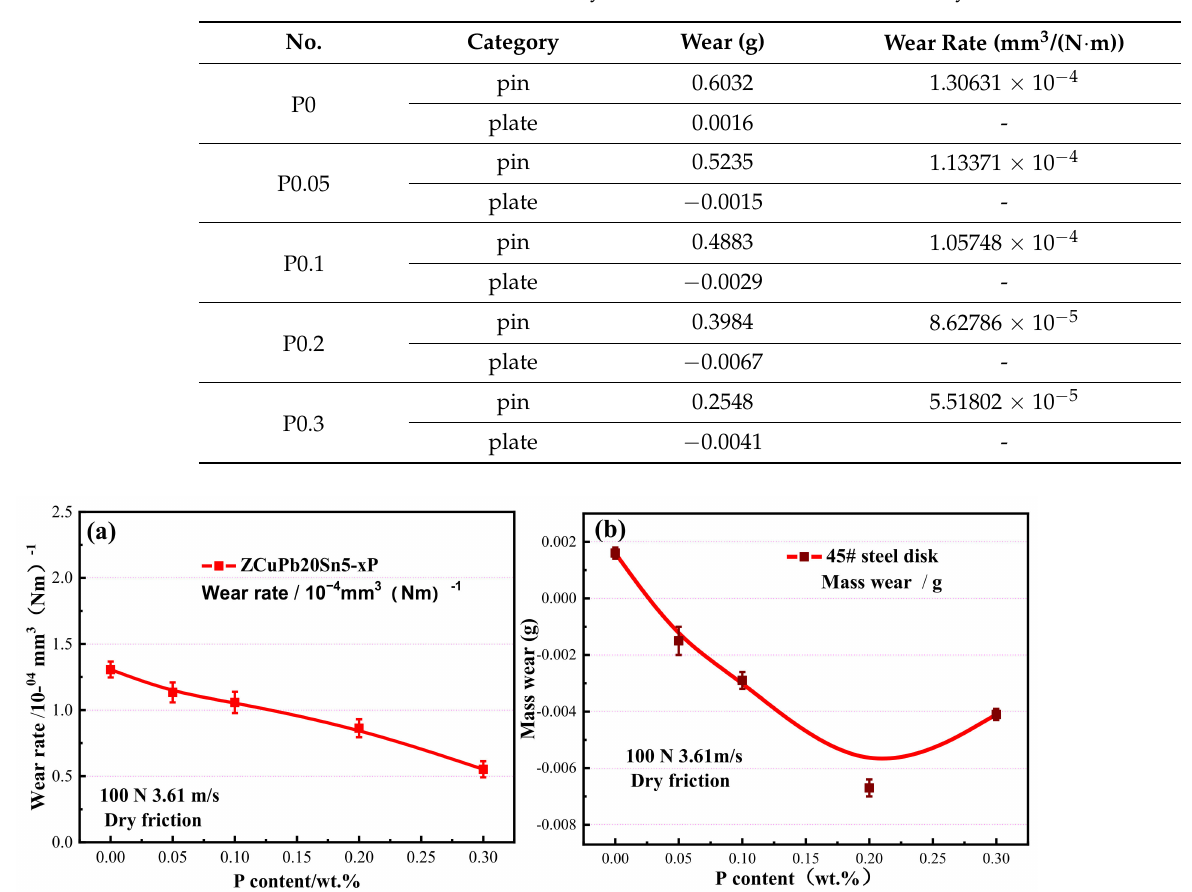
Figure 4. Abrasion of ZCuPb 20 Sn 5 − x P alloy and 45 # steel disc under oil lubrication; ( a ) Wear rate of ZCuPb 20 Sn 5 − x P alloy; ( b ) Abrasion of